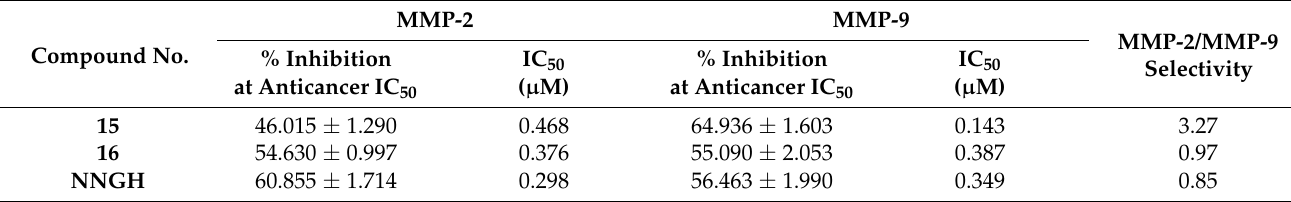
Table 3. Inhibitory profiles of 15 and 16 against MMP-2 and